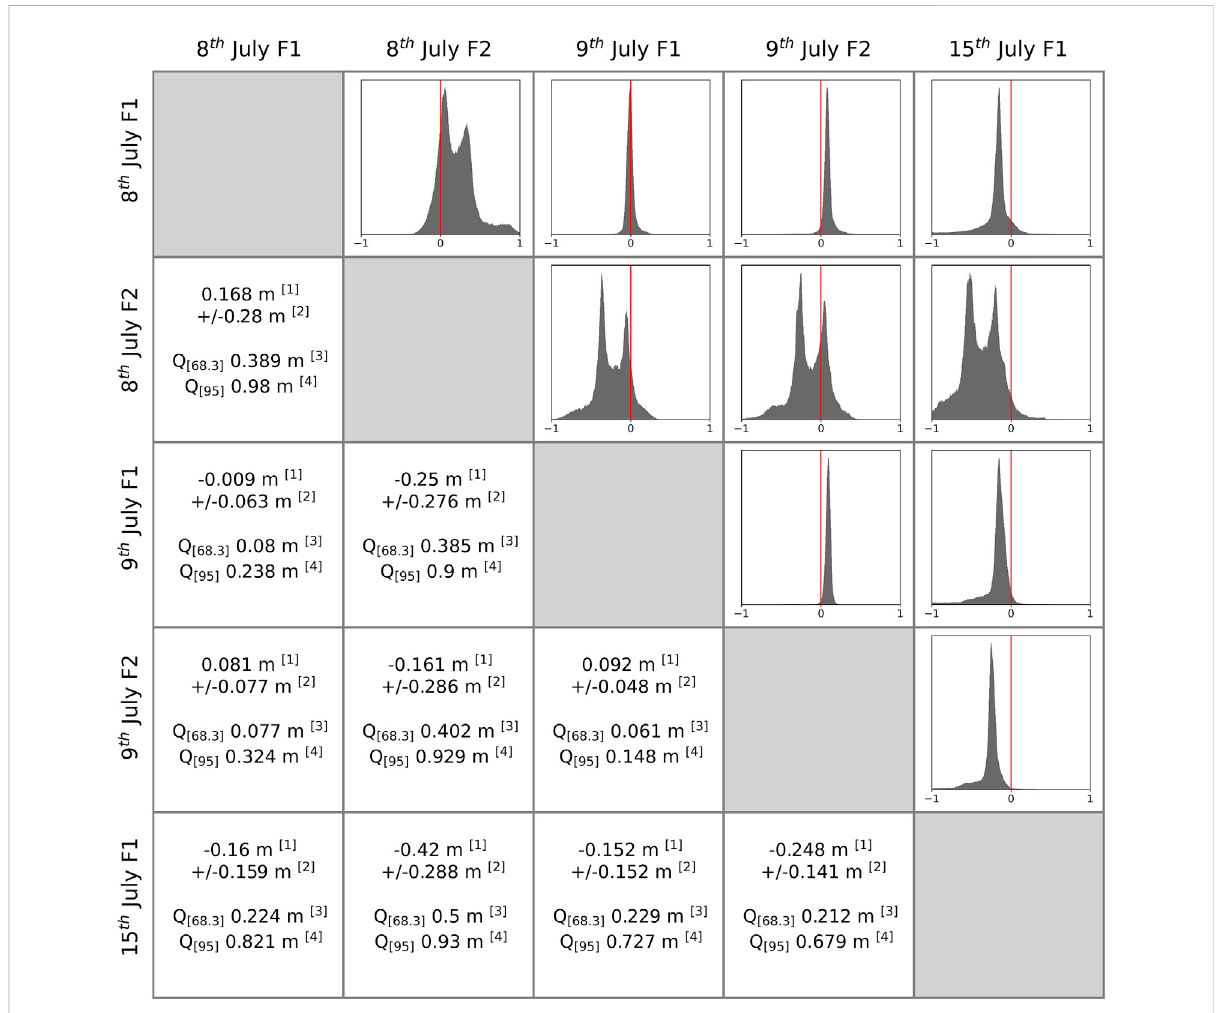
FIGURE 3 Results of the precision assessment for the UAV-LS surveys, calculated using M3C2 comparisons between each individual survey over areas of stable ground. Median [1] and NMAD [2] of errors are provided in the lower left of the matrix, alongside 68.3% [3] and 95% [4] quantiles, representing the range over which the percentage of data falls within. Histograms showing the distributionof these errors are located in the upper right of the matrix. Overall, the calculated errors are low ( < 0.23 m), indicating good agreement with each other, and in line with previous studies using these